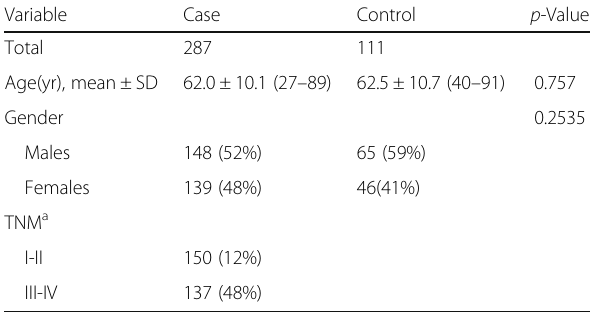
Table 1 Clinical characteristics of case and control subjects